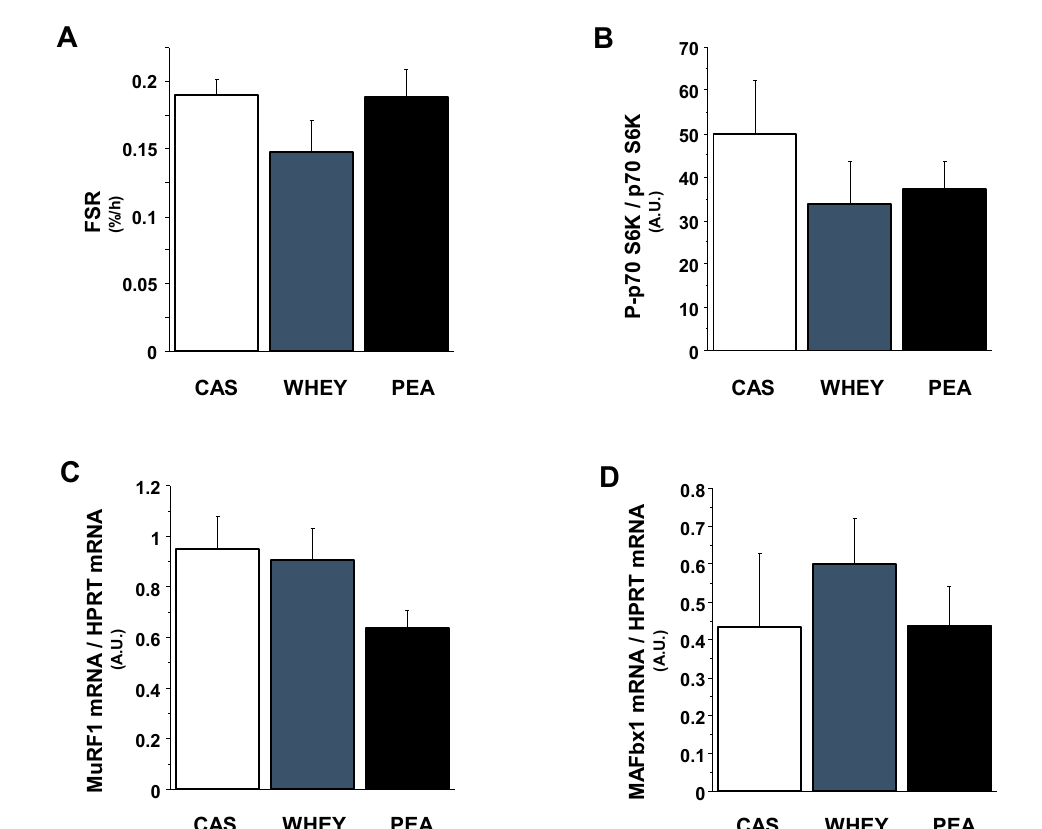
Figure 1. Effects of different experimental diets on protein synthesis and expression of ubiquitin-proteasome pathway markers in plantaris muscles of old rats. Fractional synthesis rate ( A ) was measured by tracer enrichment in plantaris muscles after a 50-min incubation with L-[ 13 C 6 ] phenylalanine. In the same muscles, the phosphorylation states of p70 S6 kinase ( B ) were determined by Western-blotting, and the gene expressions of the two ubiquitin E3 ligases MuRF1 ( C ) and MAFbx ( D ) were analyzed by quantitative RT-PCR analysis. Statistical significance was assessed by ANOVA, followed by a Tukey-Kramer test or a Kruskal-Wallis test followed by a Steel–Dwass test depending on homogeneity of variance and normality. Data are expressed as means ± SEM. A.U.: Arbitrary units.